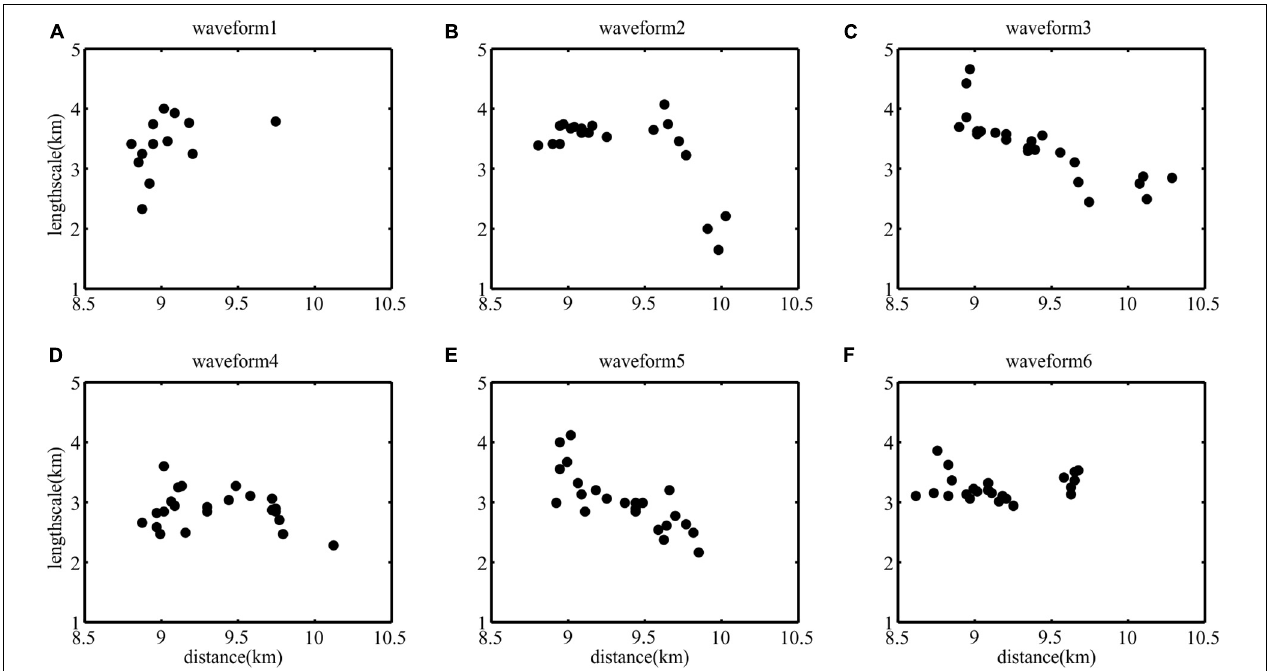
FIGURE 9 | The change in wavelength of the six waveforms. (A–F) The black dots are observed